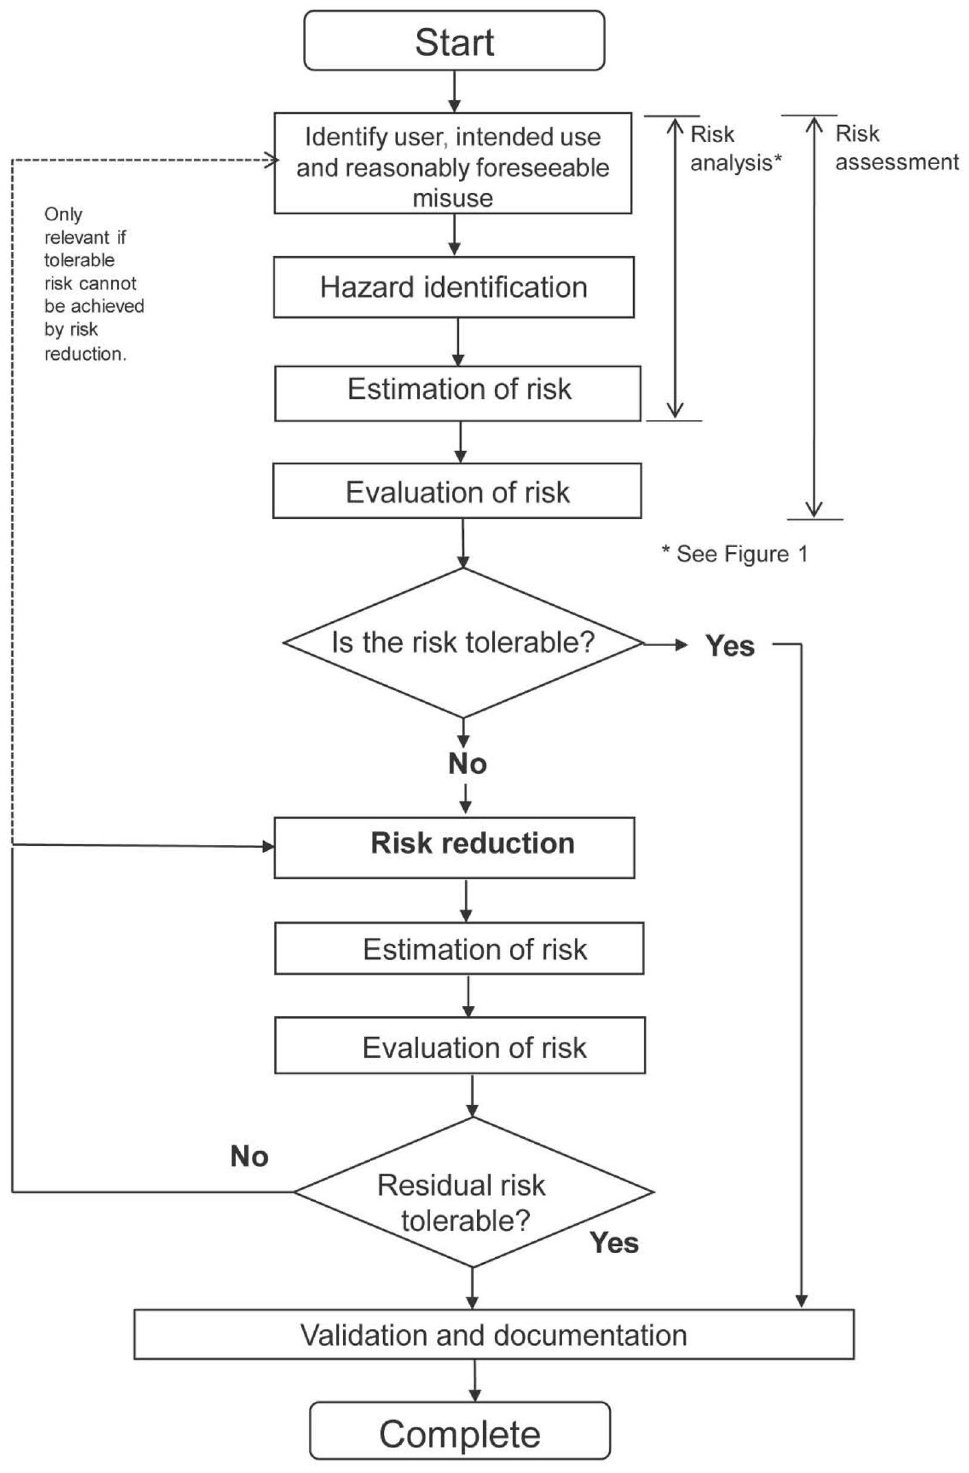
Fig. 1 ISO/IEC Guide 51 Iterative process of risk assessment and risk